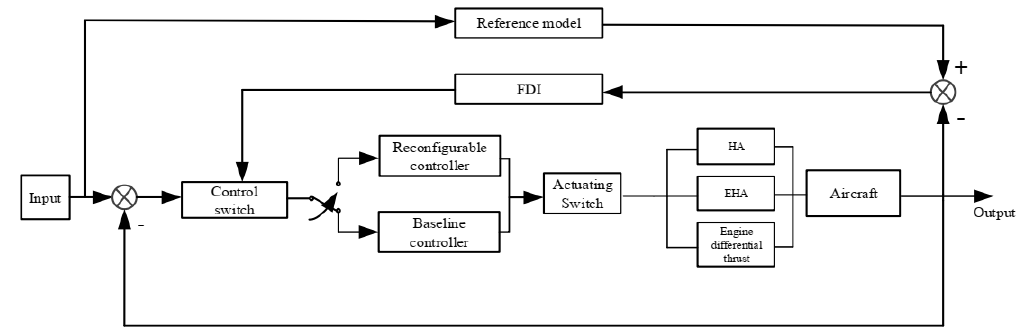
Figure 3. Structure of active fault-tolerant control strategy.